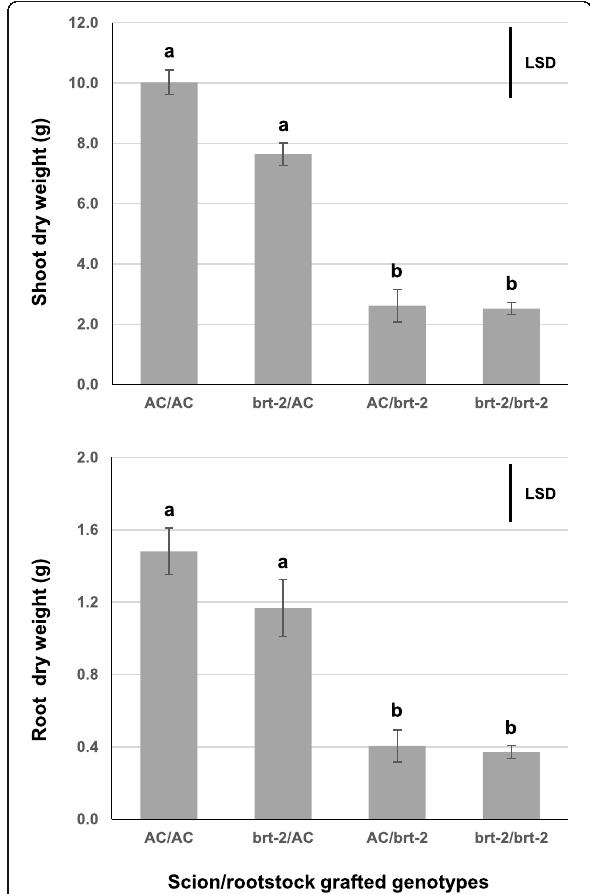
Fig. 2 Reciprocal grafting of AC and brt-2 lines. 9-week-old pot- grown plants were used for shoot (upper panel) and root (lower panel) dry weight measurements (Table S1). Standard errors are indicated, Least Significant Difference (LSD) of the one-way ANOVA are marked ( p <